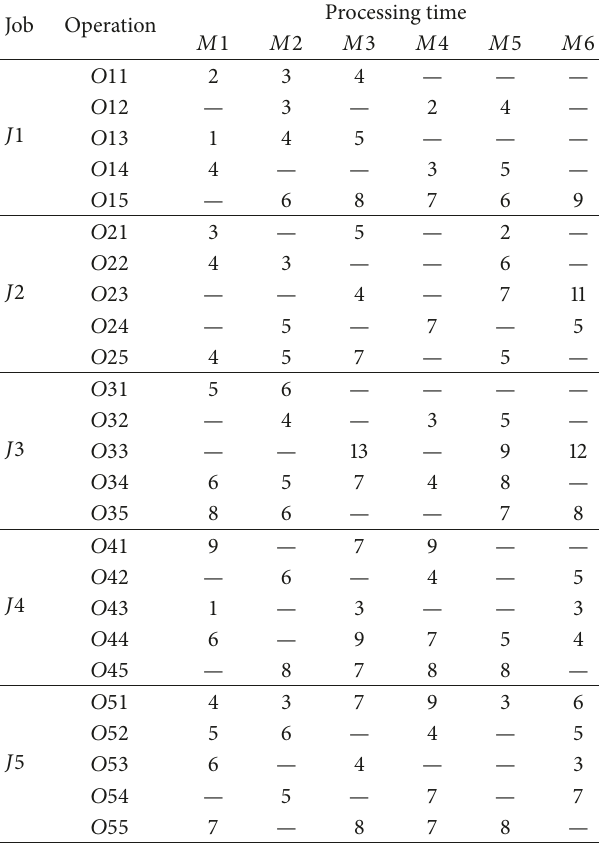
is shown in Figure 17. However, if the dynamic rescheduling strategy is carried out, the rescheduling result is shown in Figure 18. From Figures 17 and 18, it can be seen that the scheduling time is reduced by 9 units after performing our proposed dynamic rescheduling